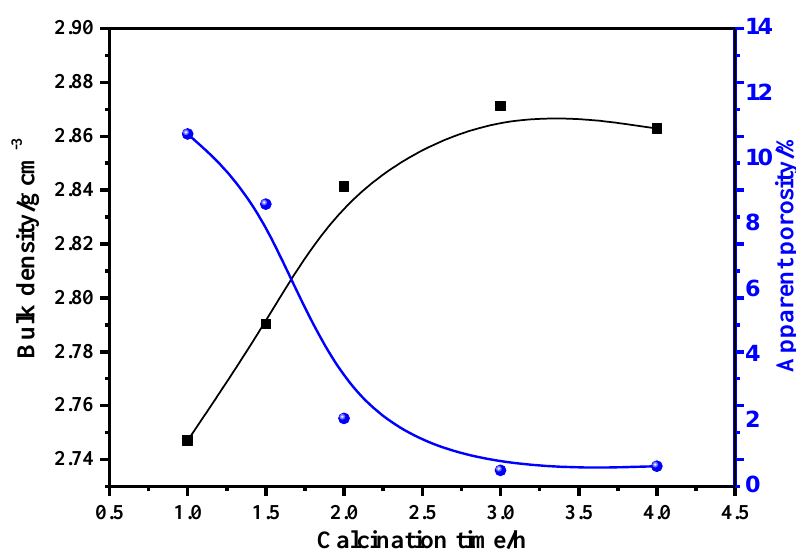
Figure 10. Effects of calcination time on mullite properties.